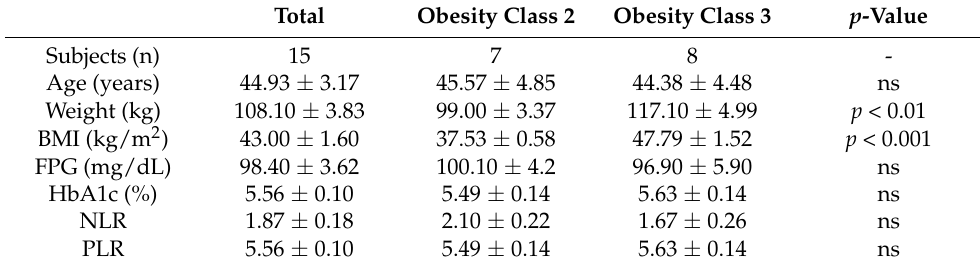
Table 1. Study subjects’